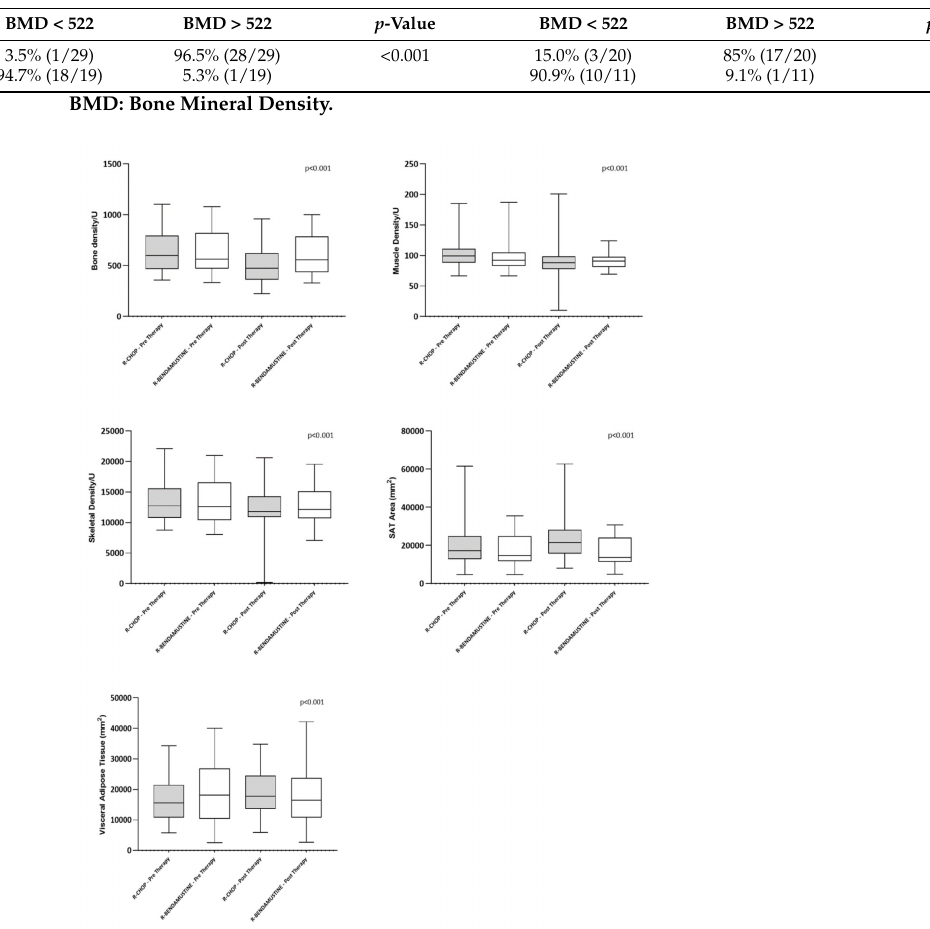
Figure 2. Boxplot of BMD, PMD, SMA, SAT, and VAT at baseline and after